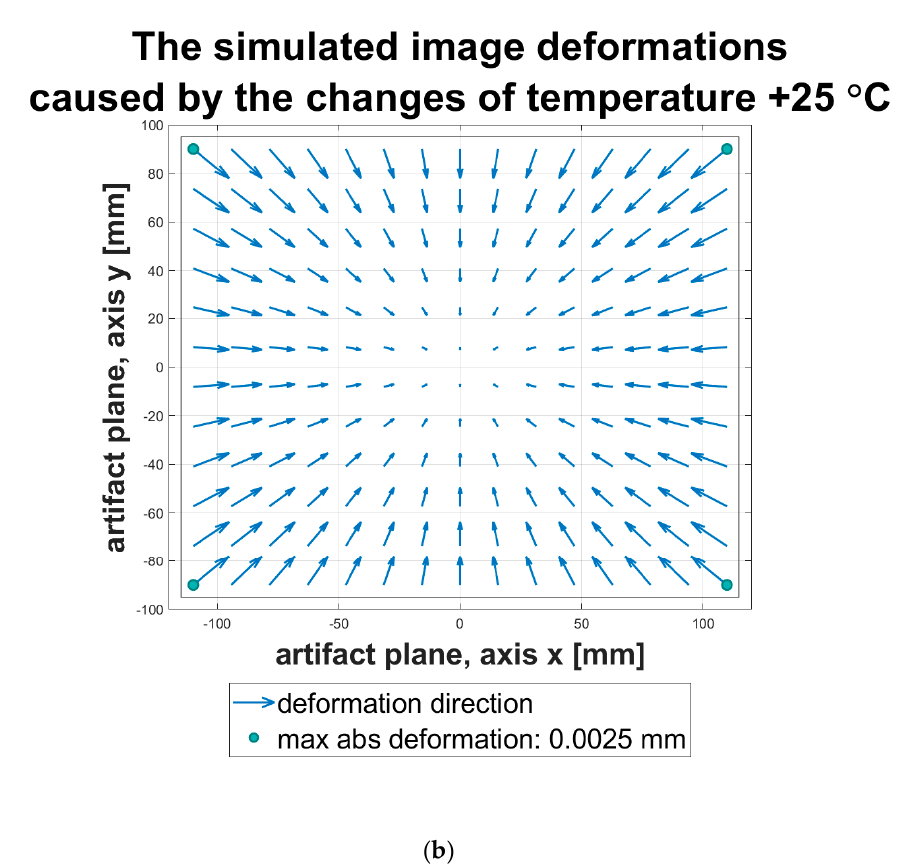
Figure 3. ( a ) The geometry of the test stand used for simulation. The blue line represents the optical axis of the tested camera. The red camera ray is refracted while leaving the thermal chamber due to the changes in the refractive index of air caused by the temperature difference. ( b ) The simulated deformations in the calibration artifact plane caused by the increase in temperature of +25 °C.